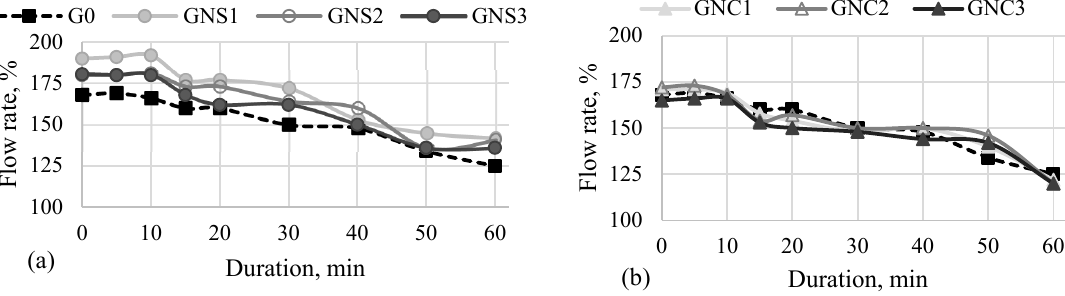
Figure 4. Flowability of cement pastes during 60 min. ( a )—reference sample and sample with NS; ( b )—reference sample and sample with NC.